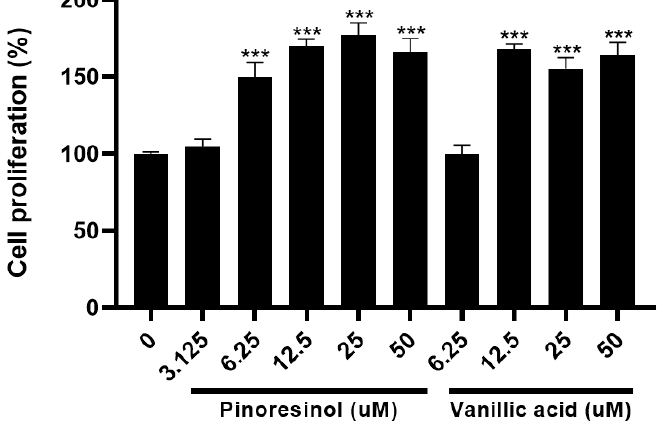
Figure 3. Pinoresinol and vanillic acid facilitating proliferation of mouse myoblasts in a dose- dependent manner. Cell proliferation activity measured by BrdU assay of pinoresinol and vanillic acid at various concentrations on C2C12 cells during the differentiation period. Data represent the mean ± SEM, obtained from at least triplicate determinations. *** indicates p < 0.001 calculated by one-way